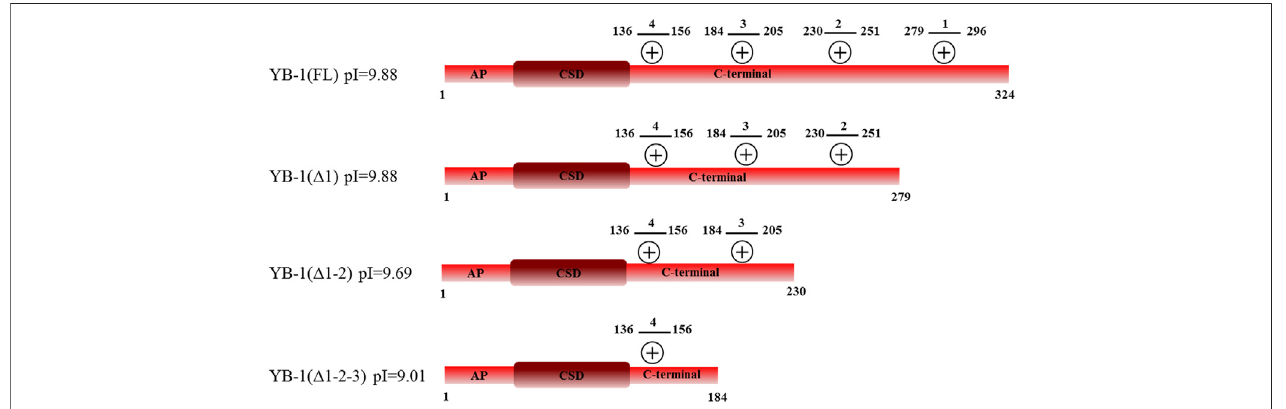
FIGURE 1 | Domain structure of YB-1(FL) and its C-terminal deletion mutants: YB-1 ( Δ 1), YB-1 ( Δ 1-2), and YB-1 ( Δ 1-2-3). Designations: alanine/proline-rich (AP) domain, cold-shock domain (CSD), C-terminal domain (CTD) carrying four clusters (1 279-296 , 2 230-251 , 3 184-205 , 4 136-156 ) of positively charged residues (+).